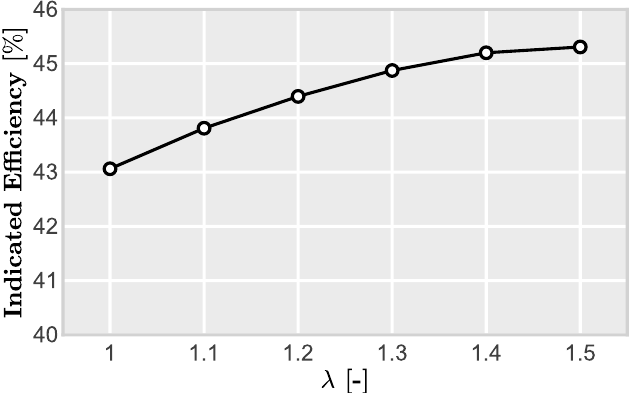
Figure 11. Indicated efficiency trends when the air dilution rate is increased from λ = 1.0 to λ = 1.5 using methane as